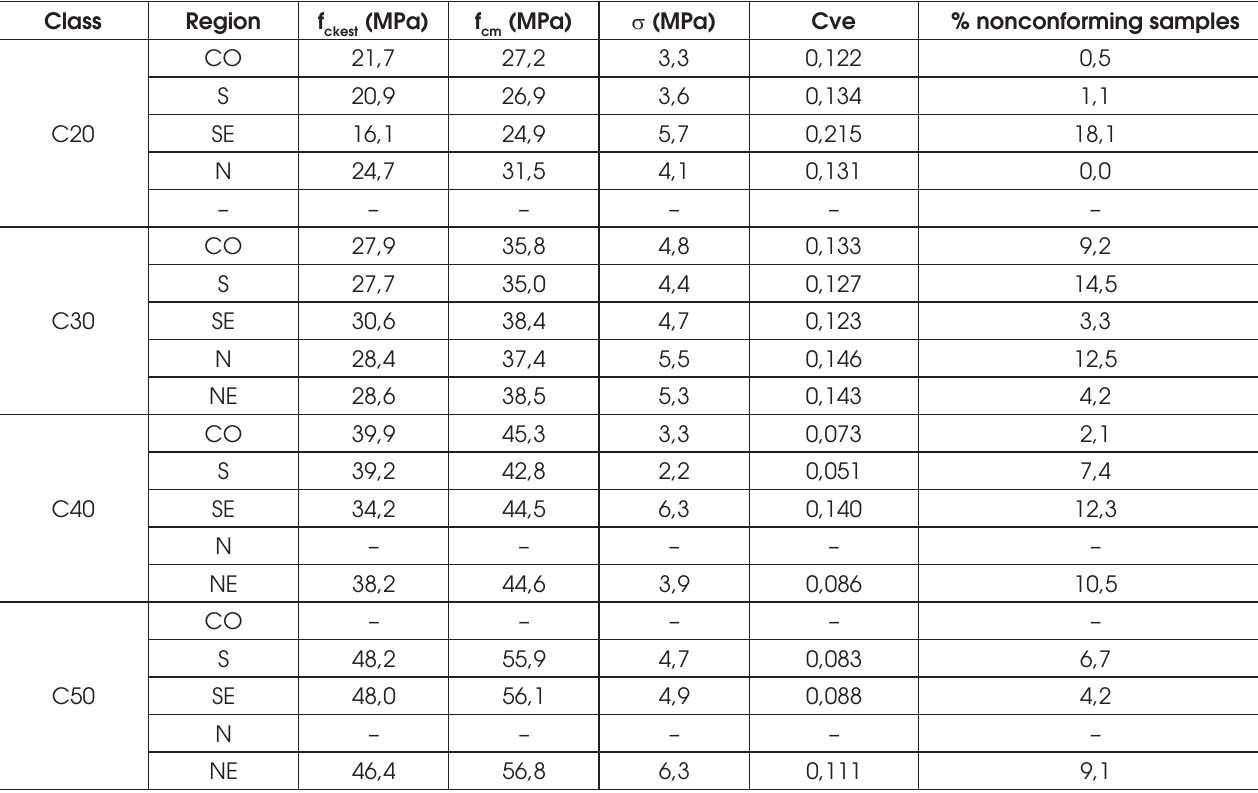
Summary of the concretes produced in the different regions of Brazil